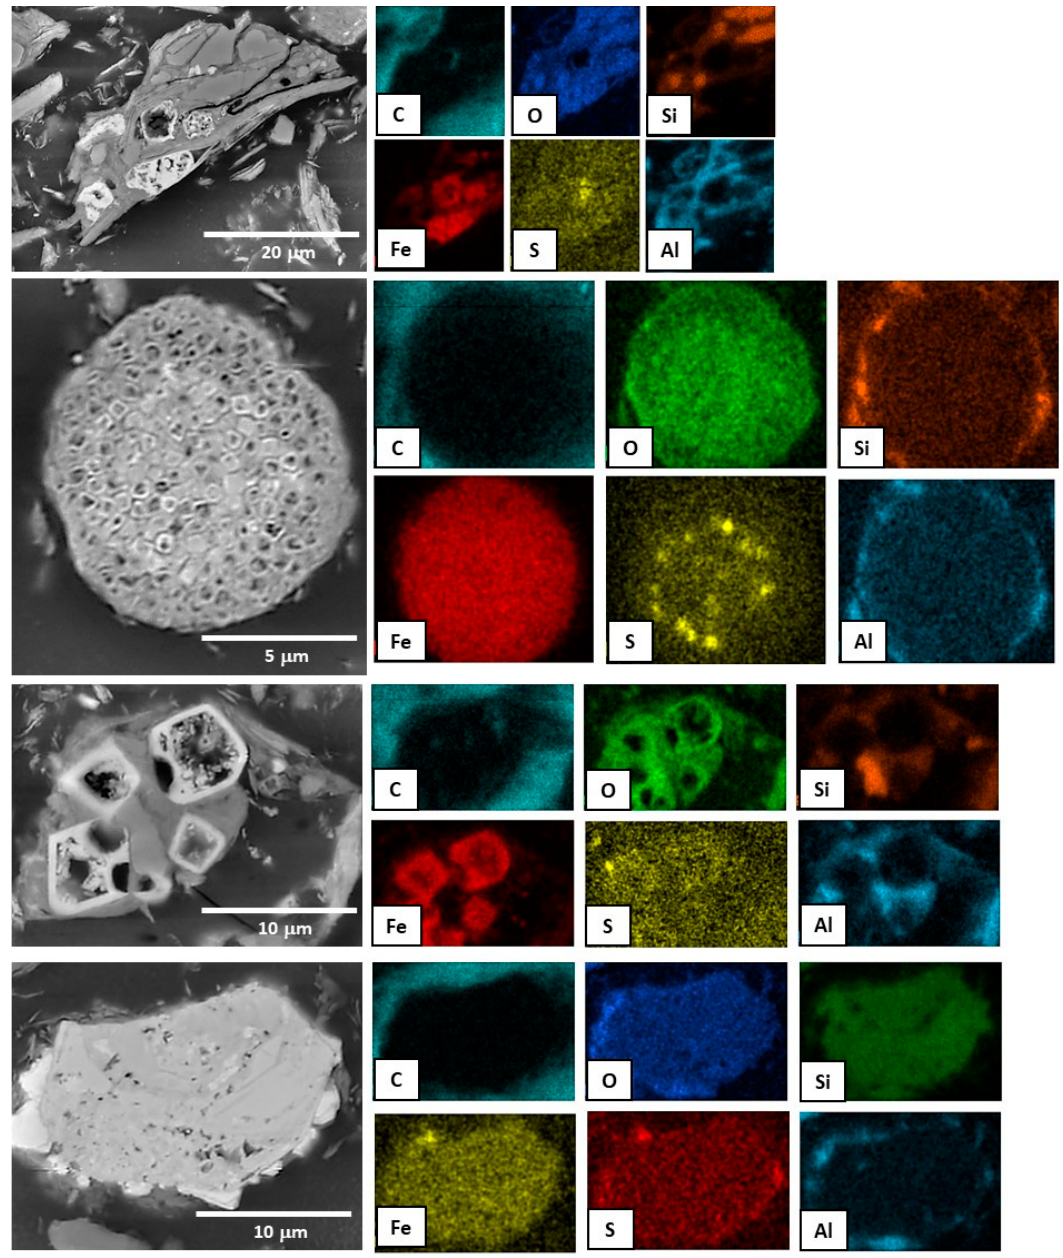
Figure 3. Representative SEM images collected in the backscattered mode and EDS element maps from the high wall soil samples from 0–10, 30–40, 70–80, and 110–120 cm (in descending order).